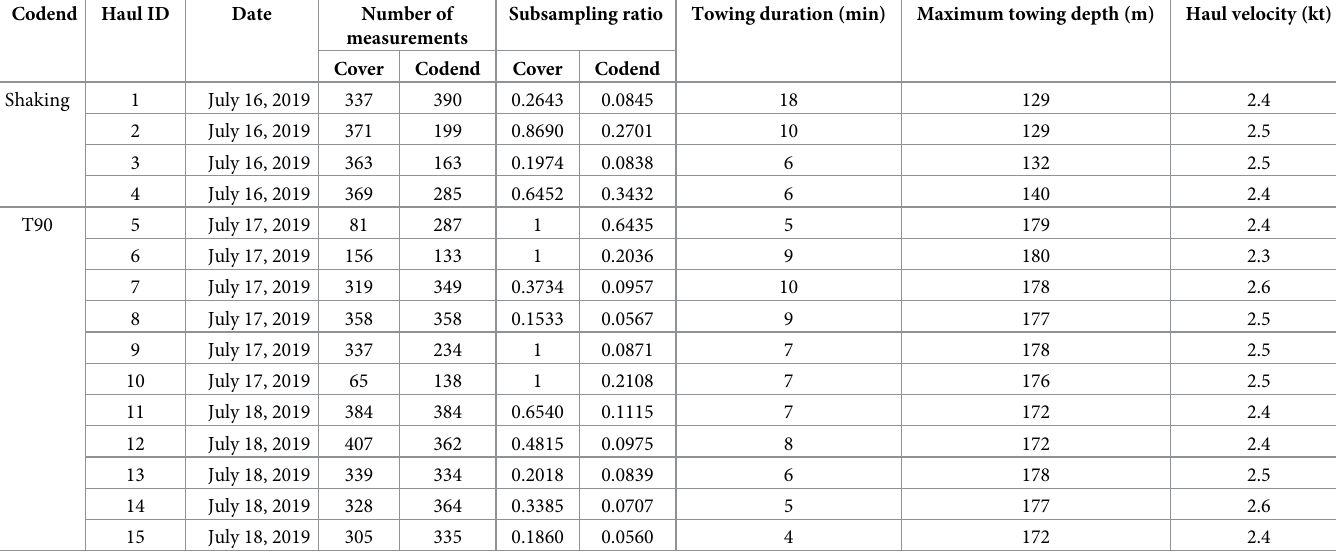
Table 3. Operational conditions for sea trials testing the size selectivity of shaking and T90 codends. Codend Haul